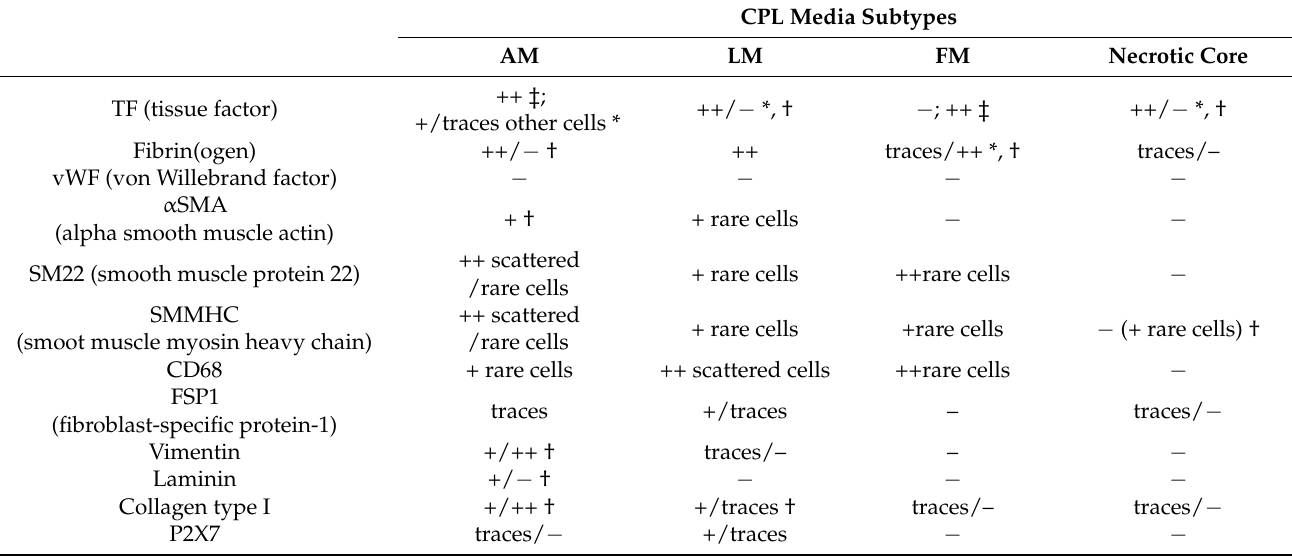
Table 2. Semi-quantitative evaluation by confocal microscopy of marker expression: CPL Media subtypes. CPL Media